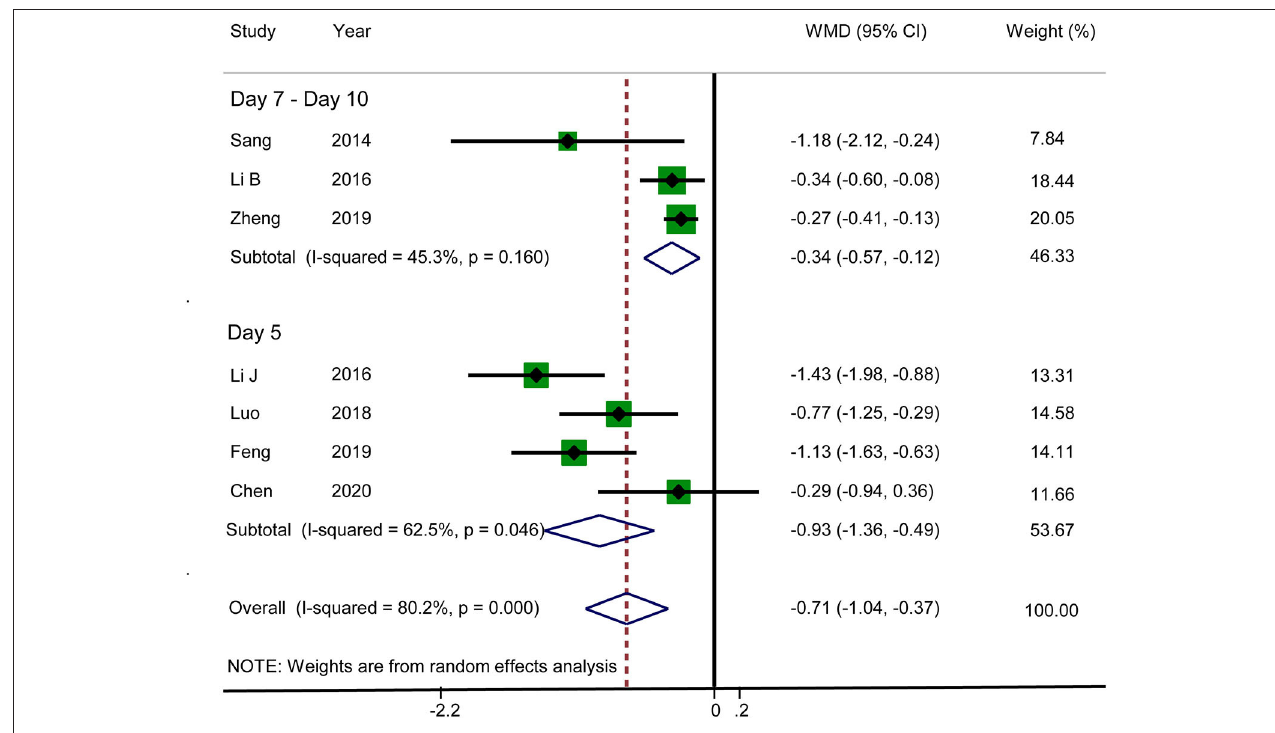
FIGURE 5 | Meta-analysis of VAS score for abdominal distension.